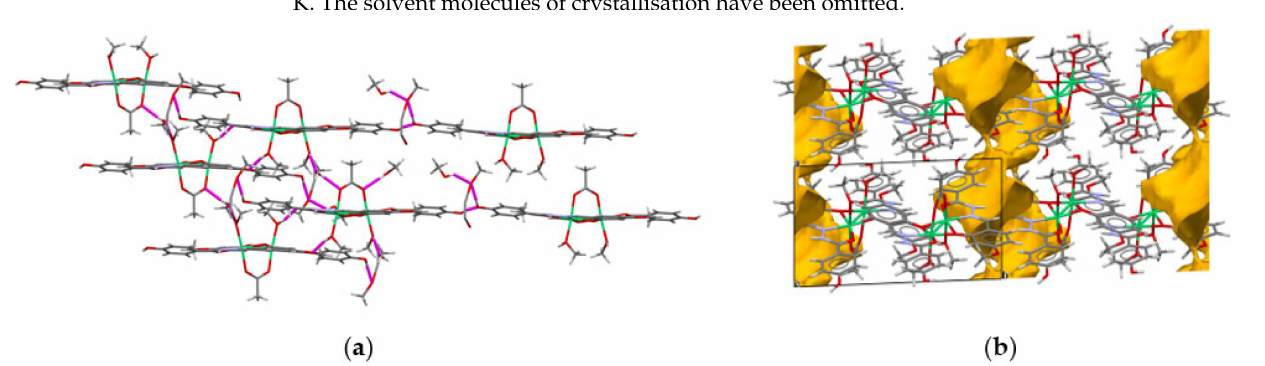
Figure 4. ( a ) View of supramolecular structure of 2 · 4.7MeOH. The hydrogen bonds (dashed magenta lines) net complex molecules and methanol molecules of crystallisation via the O–H ··· O-type bonds. ( b ) The alternating supramolecular architecture of solvent and complex molecules spreading along the b axis (yellow voids represent channels formed by solvent molecules). Color code: Ni-green, N-blue, O-red, C-gray,